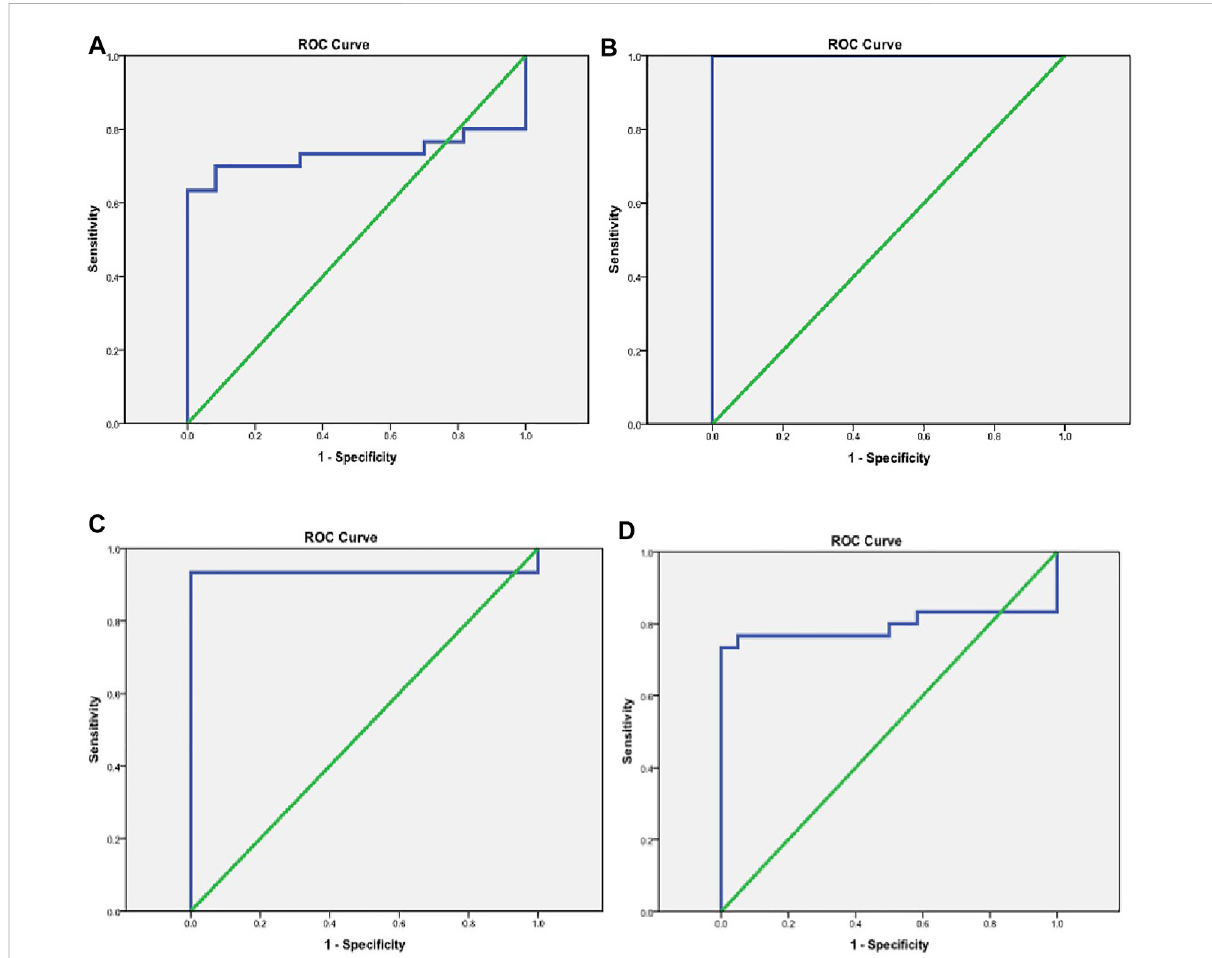
FIGURE 4 Evaluation of the diagnostic accuracy of TUG1, NBAT1, miRNA-21, and miRNA-335 serum levels. (A) A ROC curve for TUG1 in the diagnosis of AIS. (B) A ROC curve for NBAT1 in the diagnosis of AIS. (C) A ROC curve for miRNA-21 in the diagnosis of AIS. (D) A ROC curve for miRNA-335 in the diagnosis of